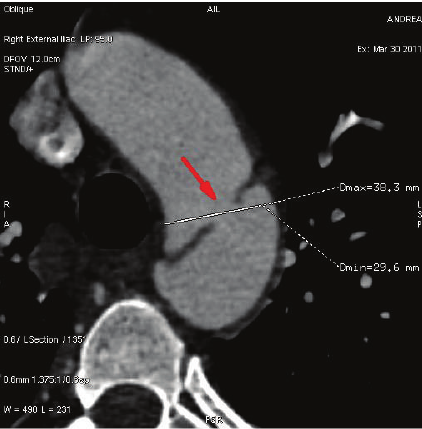
Figure 1: CTA image shows the location of tear in thoracic aorta (arrow).